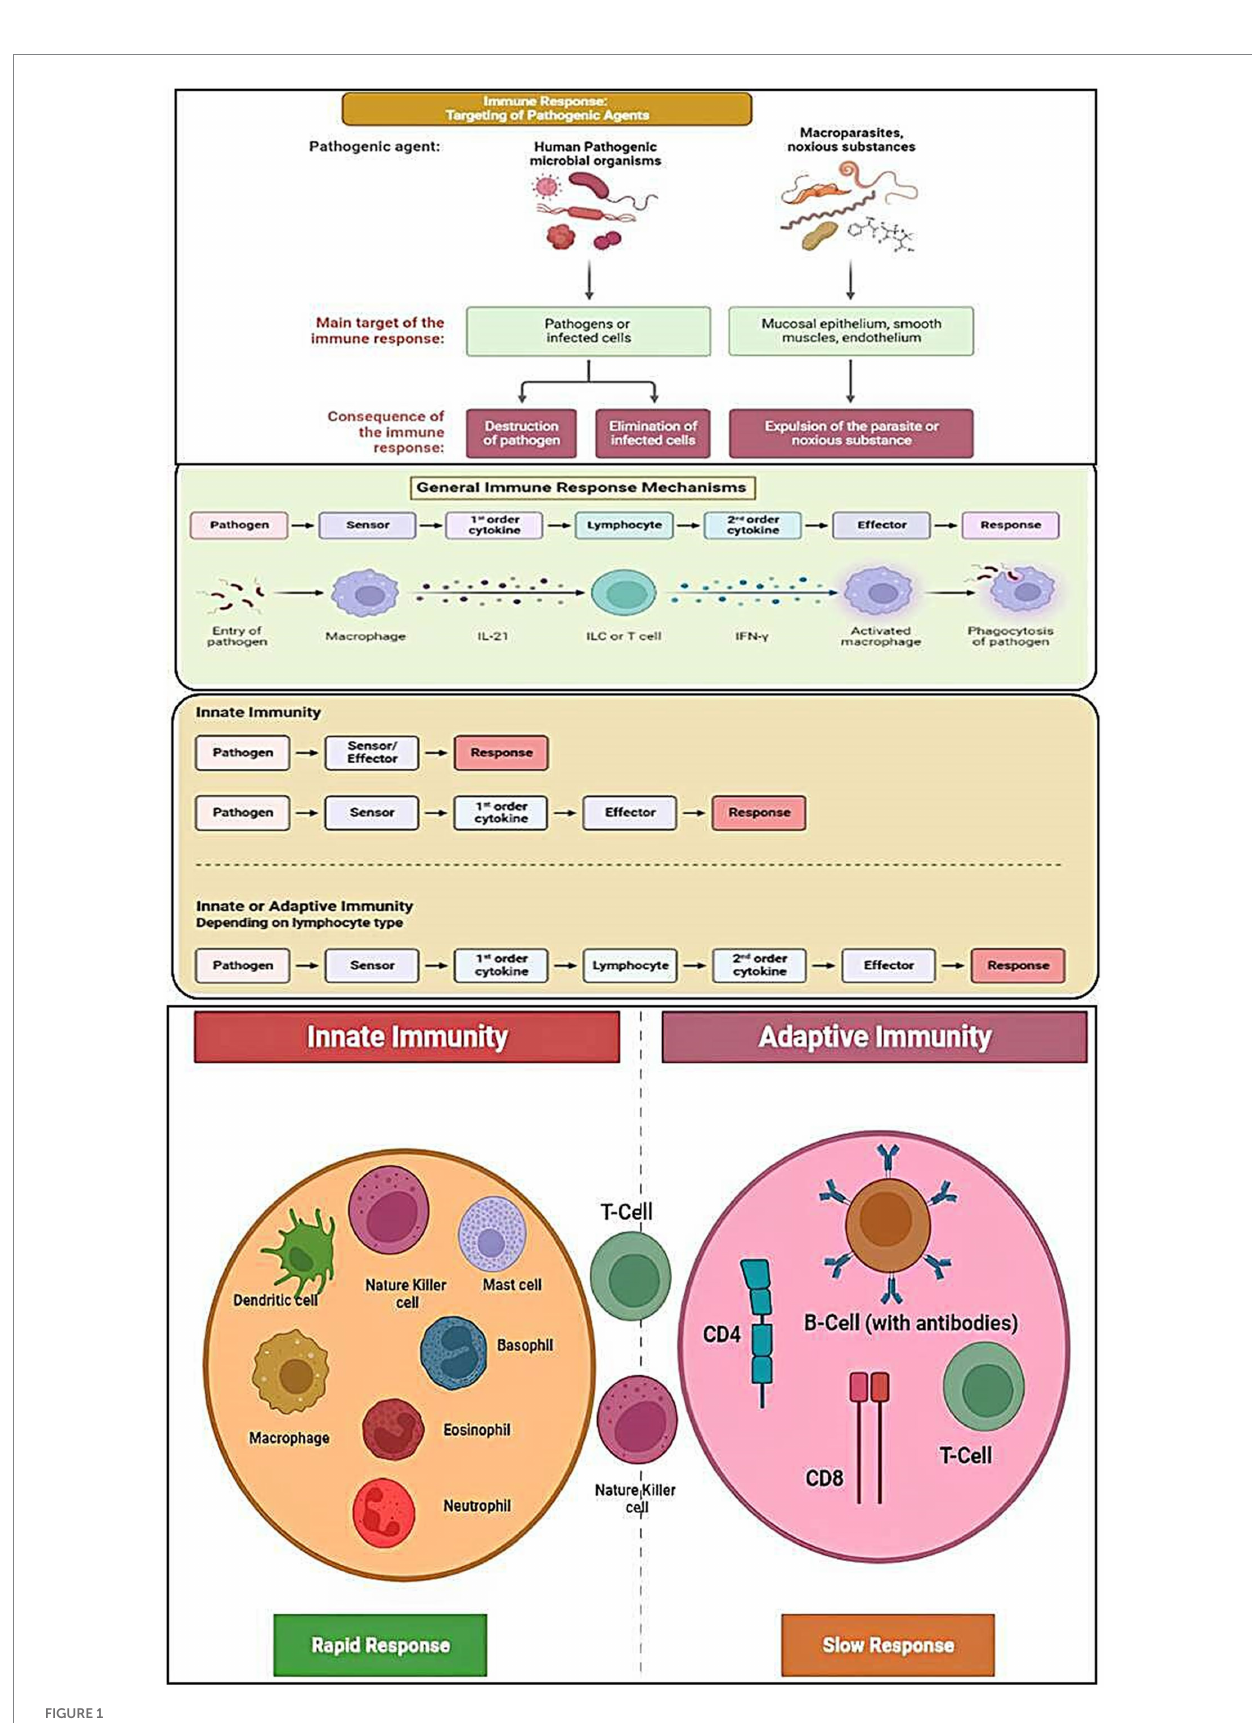
FIGURE 1 Diagrammatic representation of the process of targeting of different pathogenic agents/organisms via activation of immune responses and the general mechanisms of the innate/adaptive immune